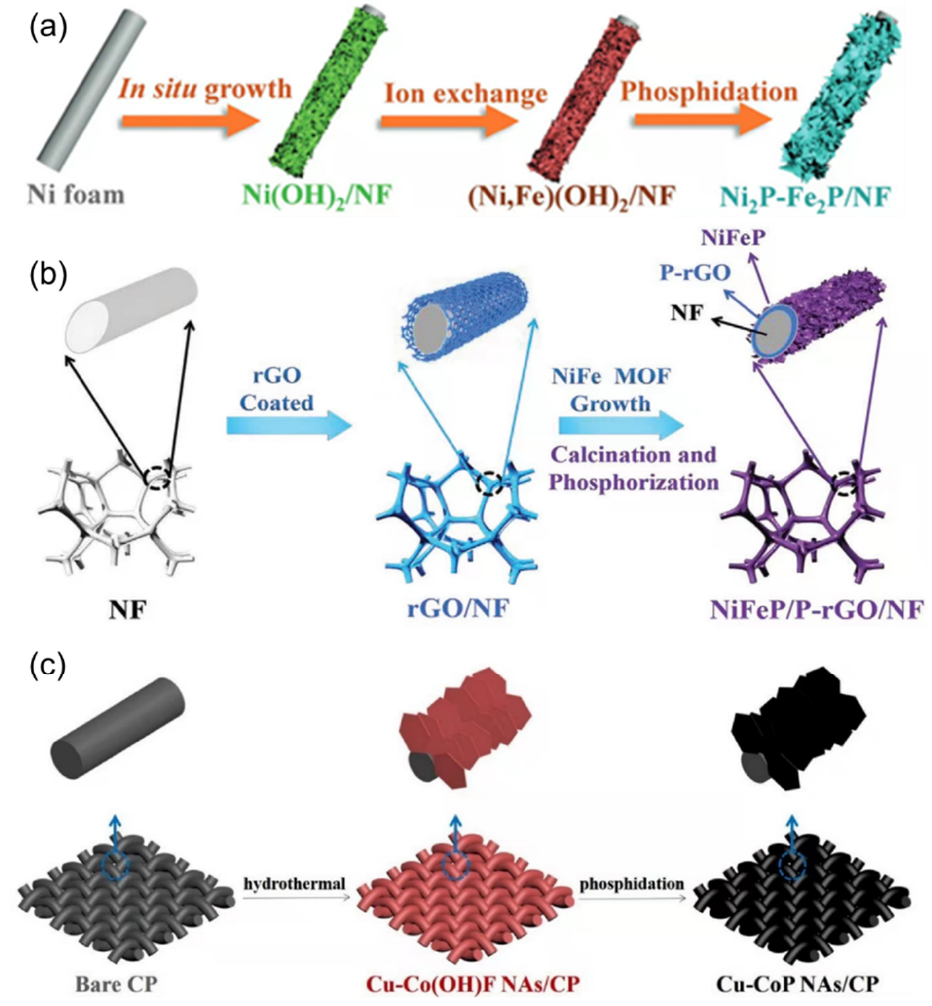
Figure 10. ( a ) The preparation process of Ni 2 P-Fe 2 P/NF [55]; ( b ) the fabrication process of NiFeP/P- rGO/NF [56]; ( c ) schematic illustration of the formation of Cu-CoP NAs/CP [57].